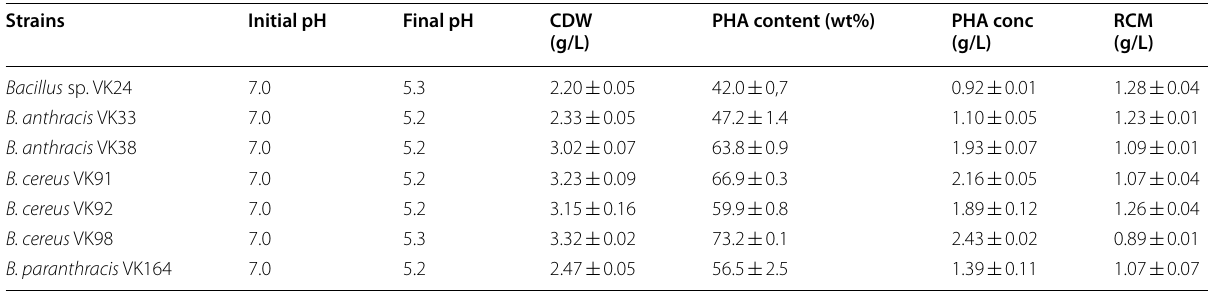
Table 3 Growth and PHA accumulation in seven Bacillus species in the medium containing 20 g/L glucose Strains Initial pH